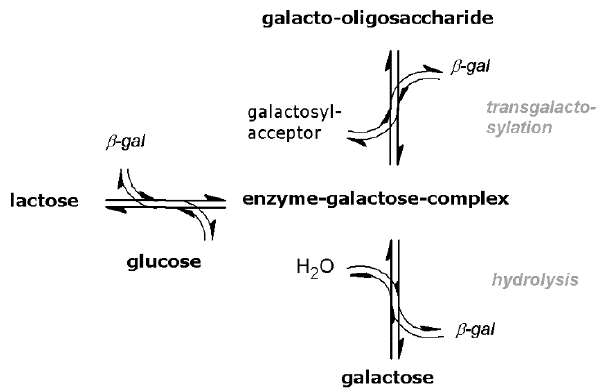
Figure 1. Equilibrium-limited reaction mechanism of enzymatic GOS synthesis with β -galactosidase